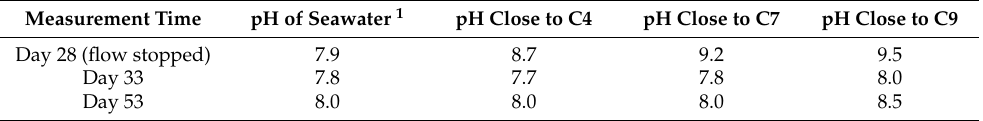
Table 1. Local pH measurements. The accuracy was estimated at ± 0.1 pH via three successive measurements. Measurement Time